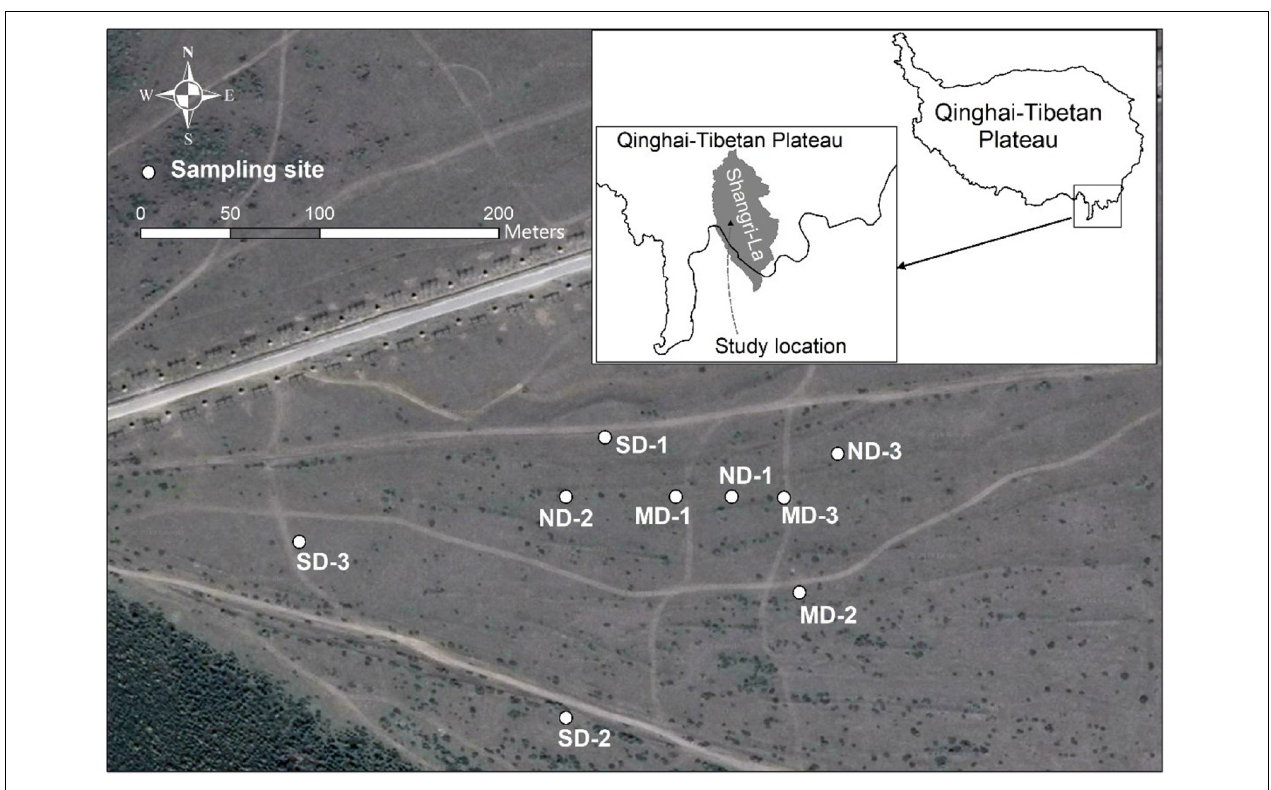
FIGURE 1 | The location of the study area and the distribution of sampling sites. TABLE 1 | The width of tourism trails (WTT), plant coverage (PC), plant height (PHt), soil bulk density (SBD), and water content of surface soil (WCSS) in no obvious degradation (ND), moderate degradation (MD), and severe degradation (SD) plots in this study ( n = 27, α = 0.05). Degradation level